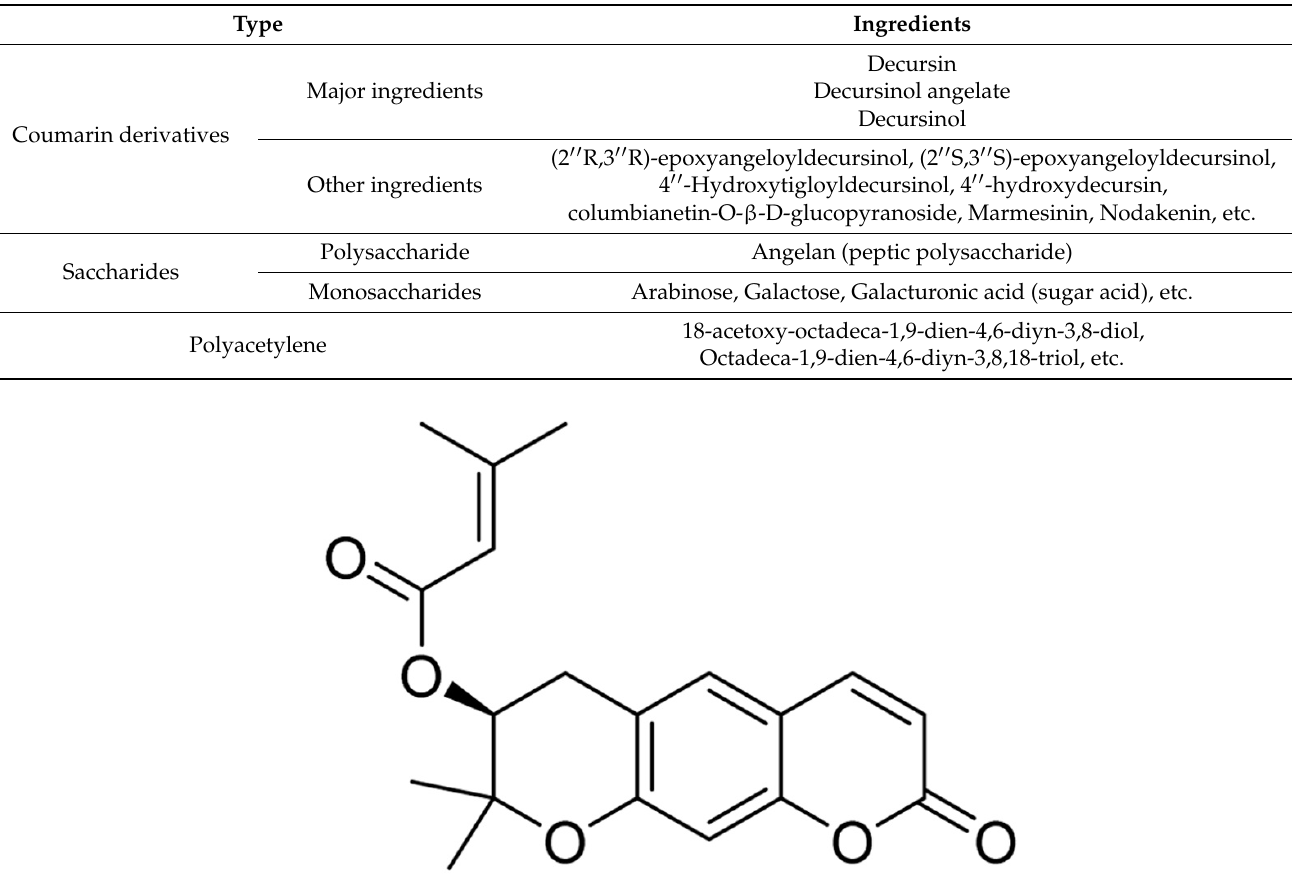
Figure 1. The chemical structure of decursin.